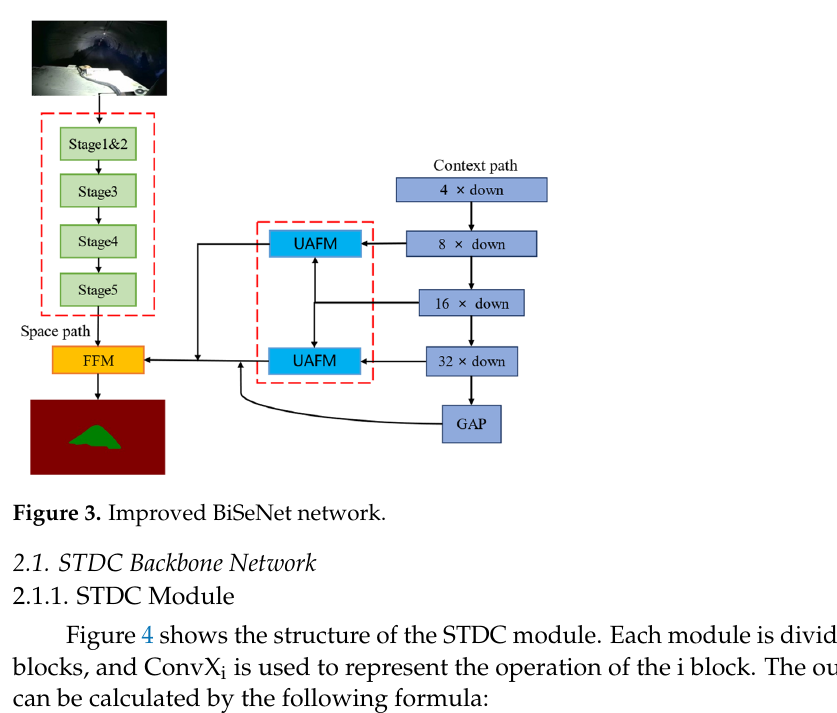
Figure 3. Improved BiSeNet network.